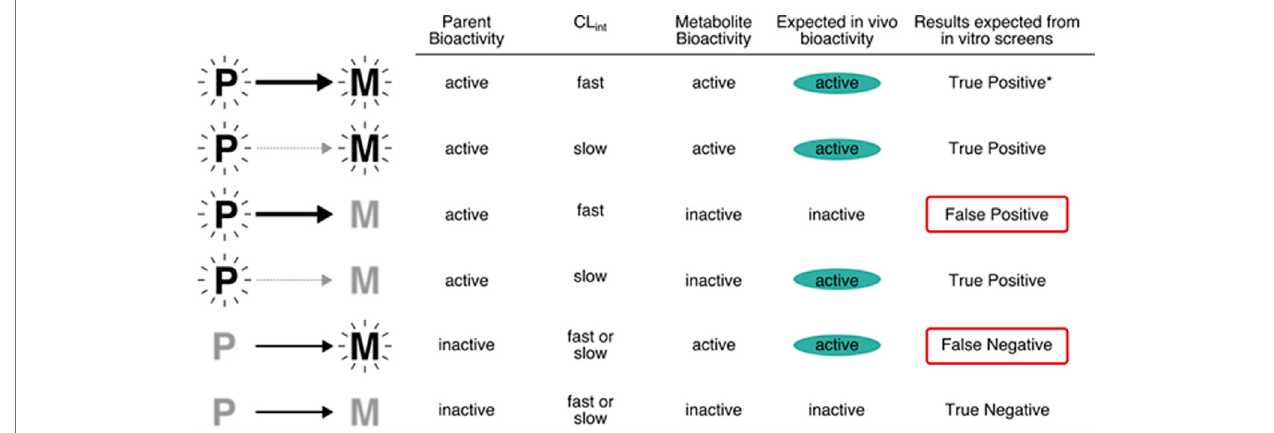
FIGURE5| Relevanceof invitro assaysthatlackmetabolismtothepotentialbioactivityofchemicals.Notethatthetoprow(denoted*),willreturnatruepositivebut for the wrong reason (because the metabolite is the entity of concern in vivo ).